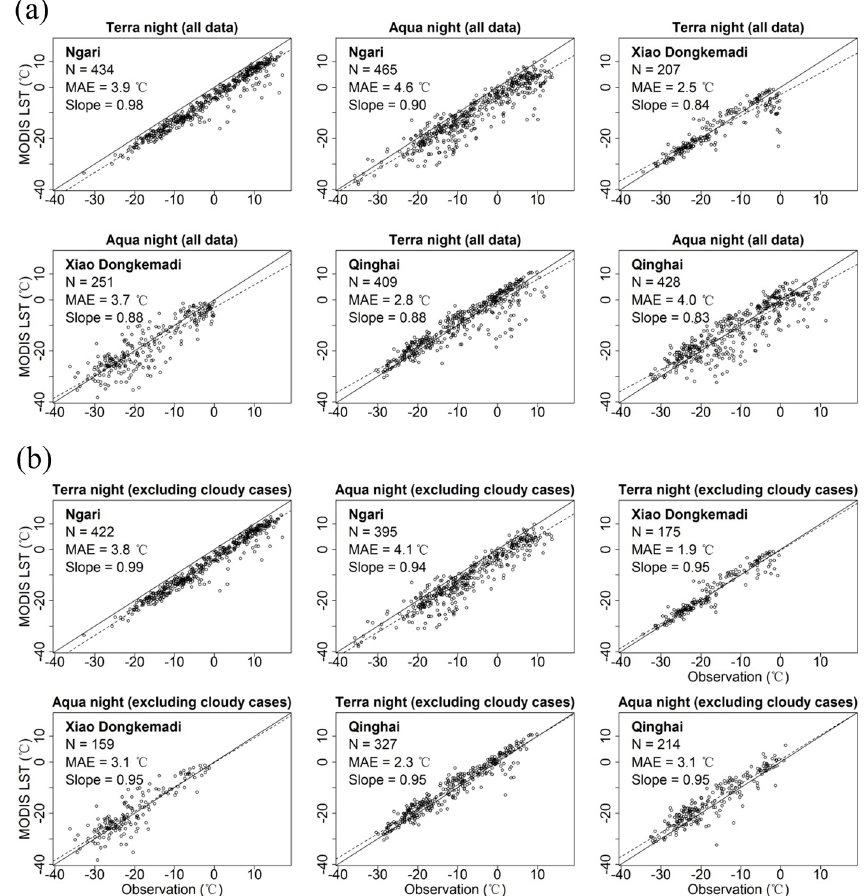
Figure 4. Validation of MODIS nighttime LST before (a) and after (b) , excluding cloudy